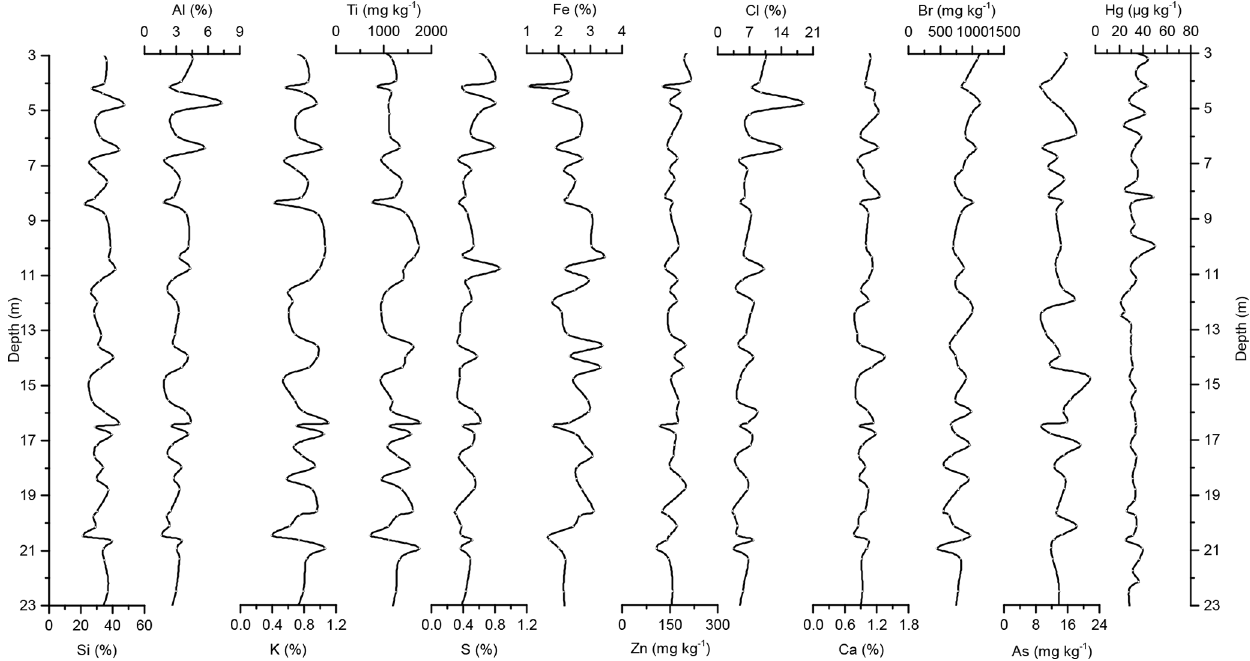
Figure 3. Down-core records of Si, Al, K, Ti, S, Fe, Zn, Cl, Ca, Br, As, and Hg concentrations of Adélie Basin sediments for the top 23m of the